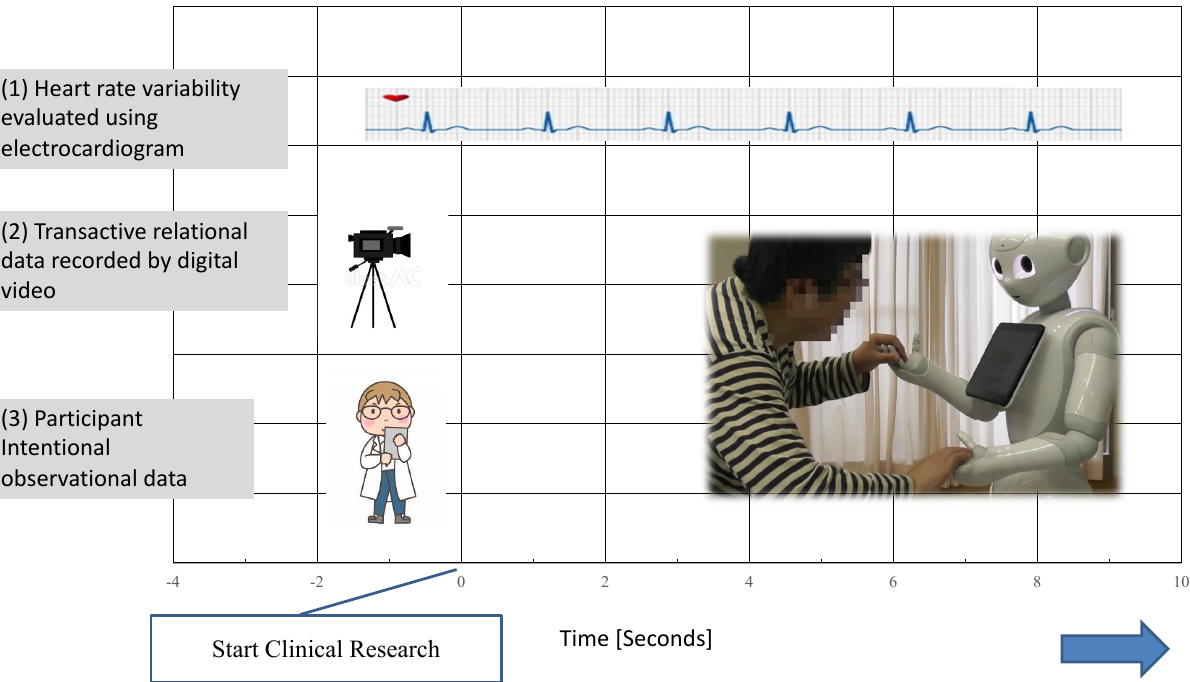
Figure 2. The framework of simultaneous research data collection using